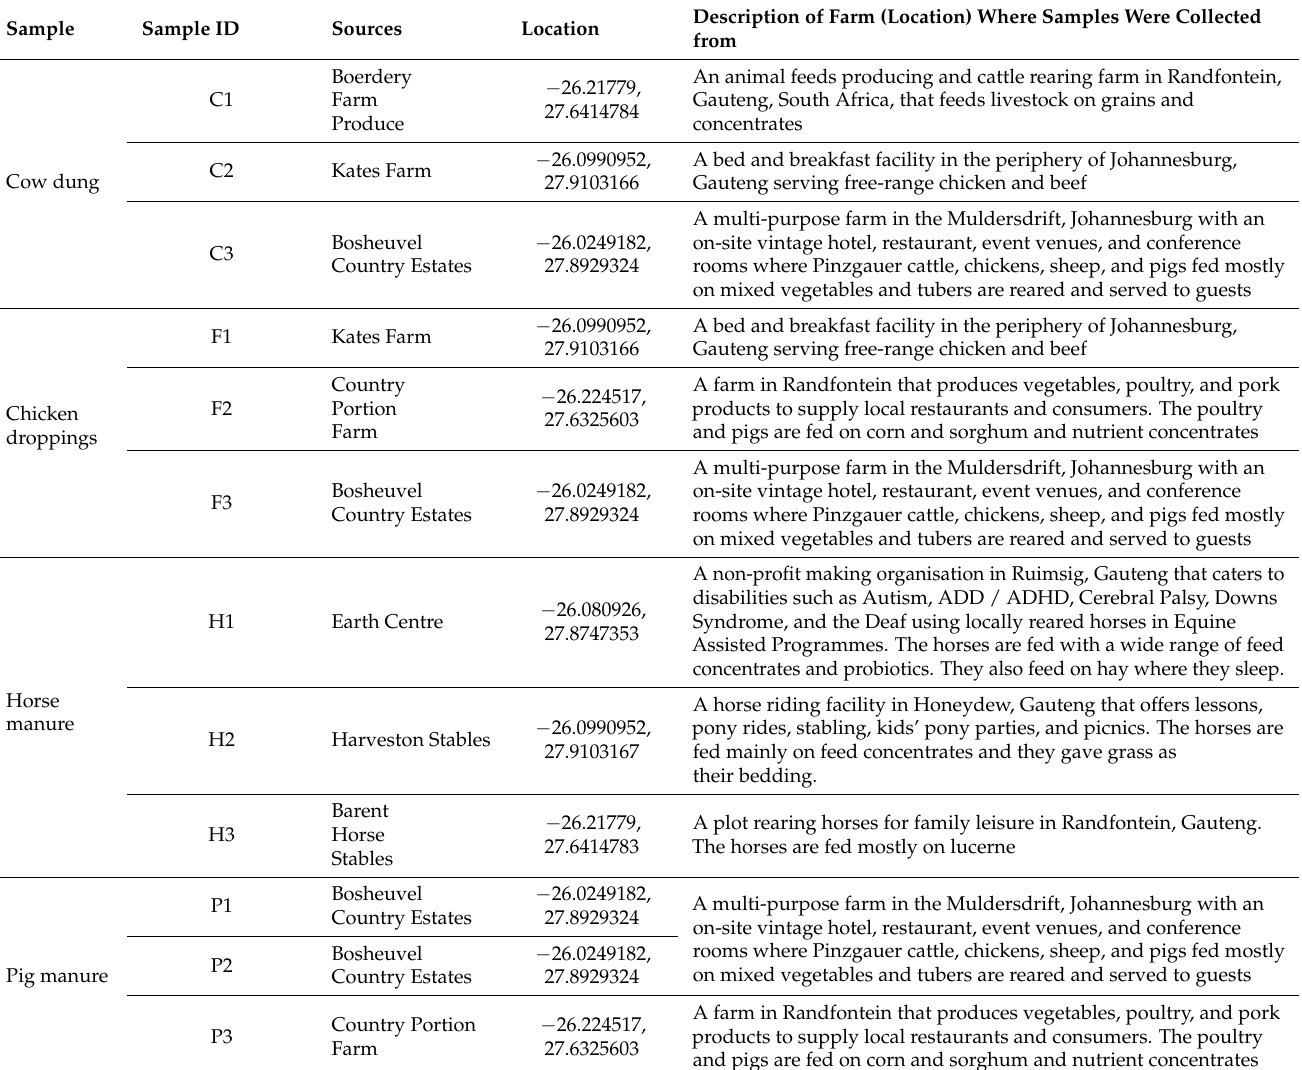
Table 1. Animal Manure Samples and